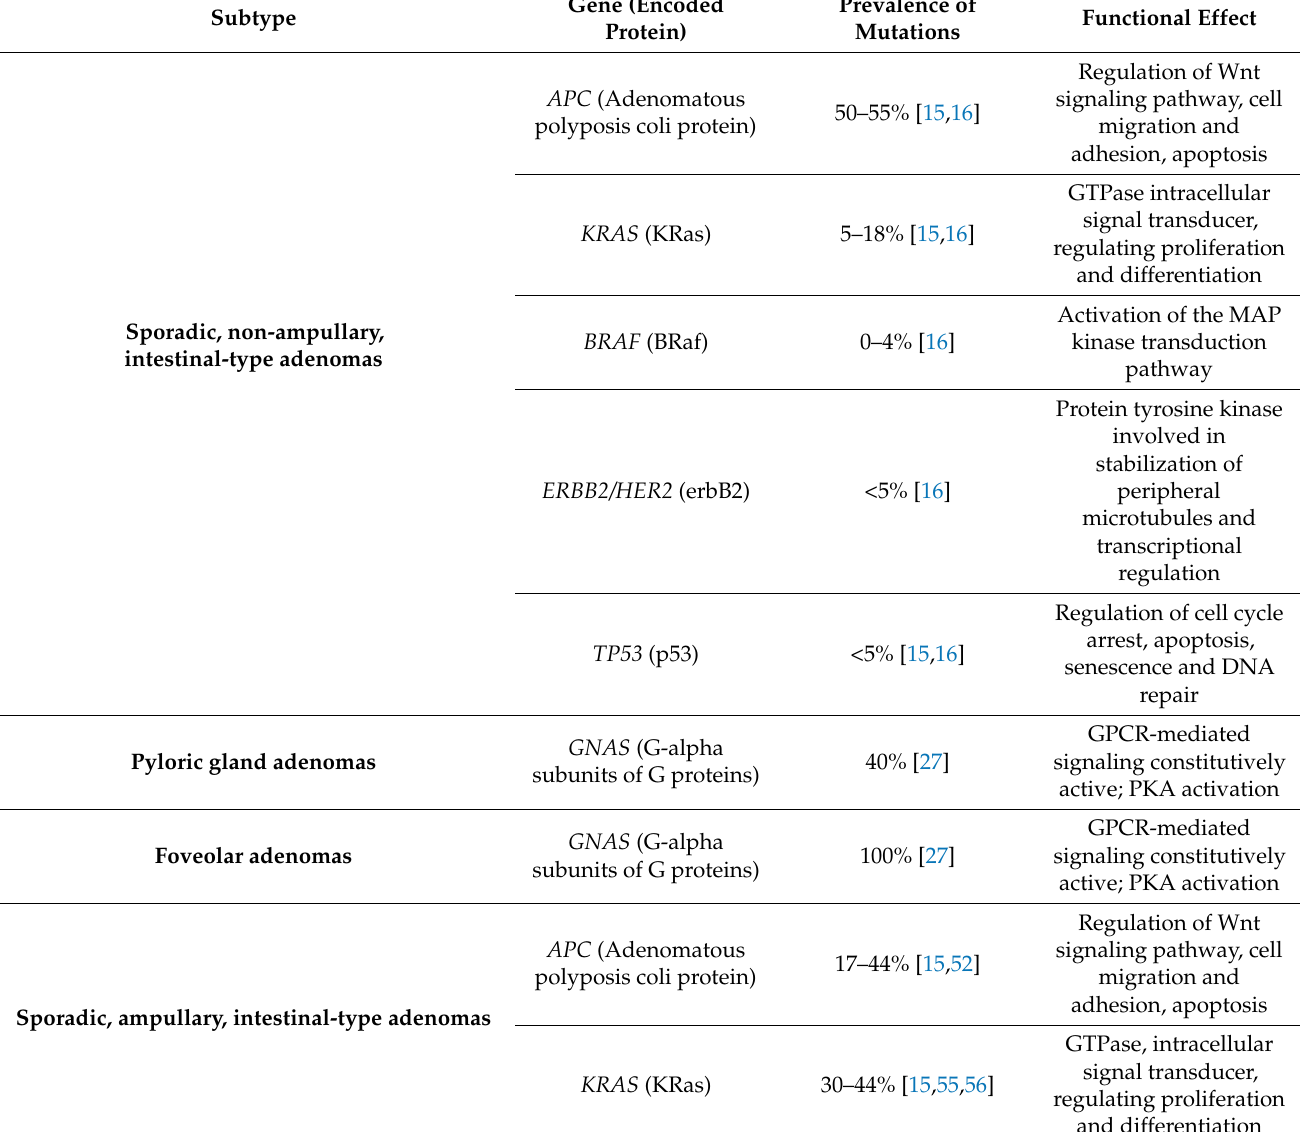
Table 1. Main genetic alterations found in small bowel precursor epithelial